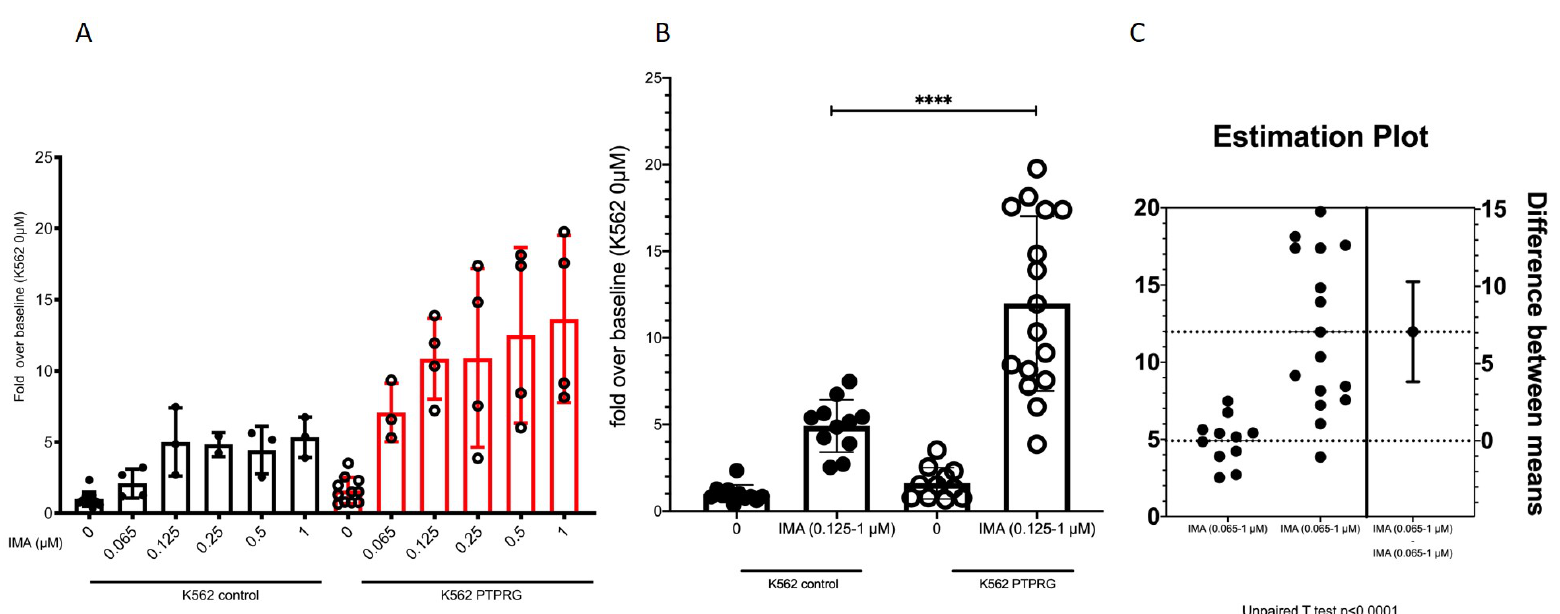
Figure 4. Up-regulation of RARG implies an increased propensity to erythroid differentiation in hemopoietic cells. ( A ) K562 cells were treated for 48 h with the indicated concentrations of Imatinib (IMA). ( B , C ) Cells were lysed, and Hb content was evaluated (ng Hb µ g total lysate) and expressed as fold increase over baseline ( p -value < 0.0001 Mann–Whitney test). In ( B ), by convention, the number of asterisks denotes the order of magnitude of the p -value: p -values less than 0.0001 are summarized with four